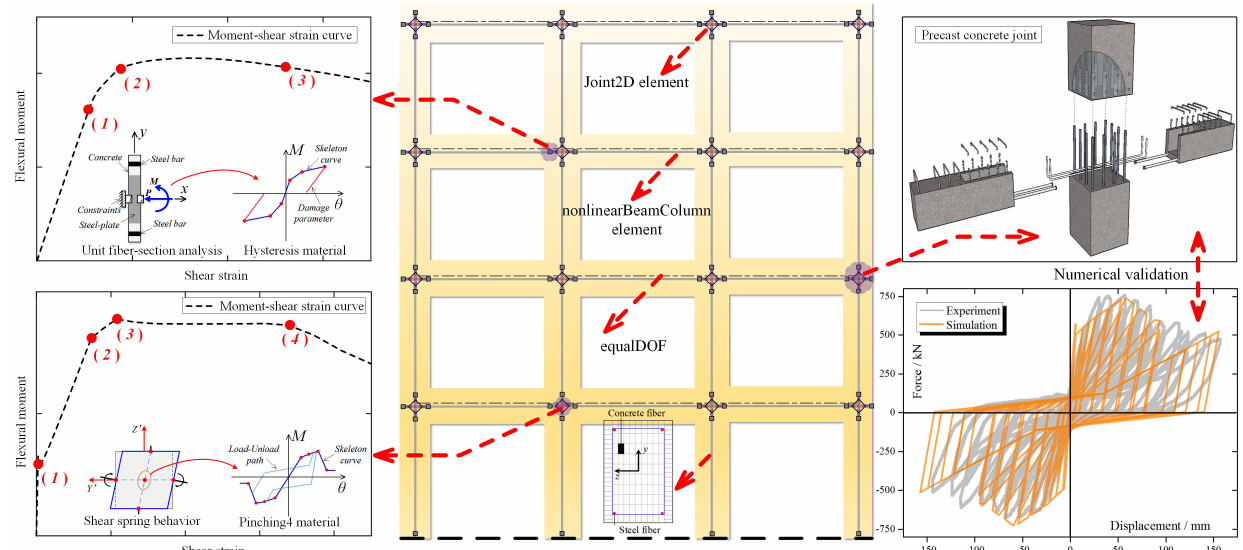
Figure 3. The simulation approach and experimental verification of a PCF in the application